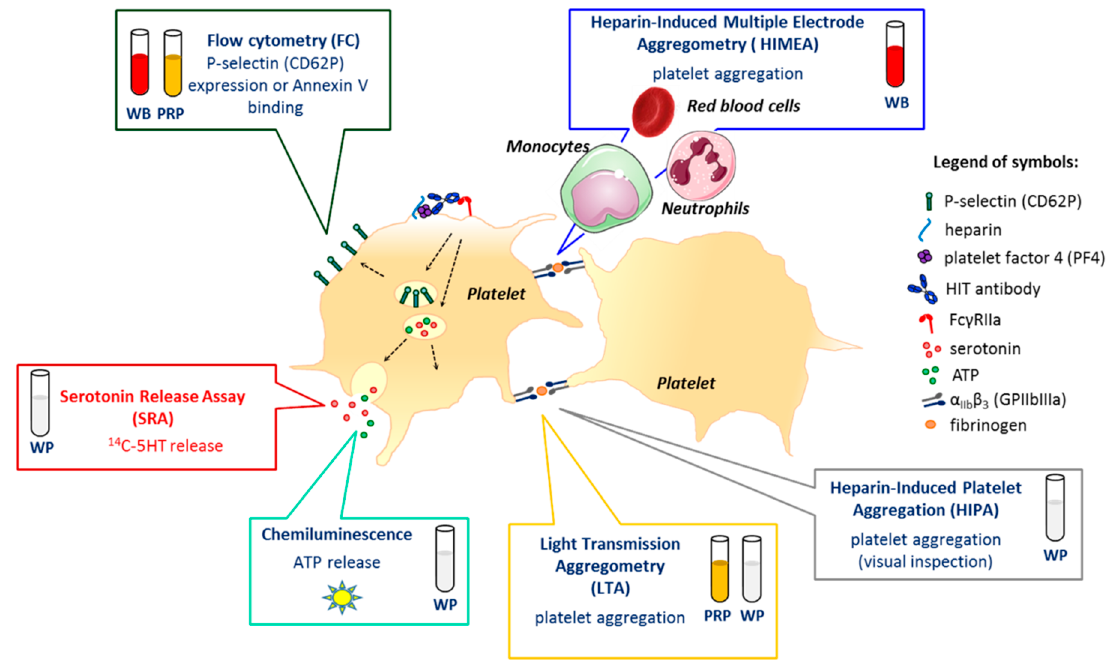
Figure 1. Platelet responses induced by heparin-induced thrombocytopenia (HIT) antibodies and functional assay targets. Depending on the assay, donors’ platelets are stimulated either in whole blood (WB), platelet-rich plasma (PRP), or after washings (washed platelets, WP). Today, serotonin release assay (SRA), which measures the release of serotonin from dense granules when platelets are activated, and heparin-induced platelet aggregation (HIPA), which is based on a visual inspection of platelet aggregates, are considered the “gold standard” to confirm HIT. The oldest but probably the most used assay is light transmission aggregometry (LTA), classically performed with PRP, but which still can also be carried out with WP. Platelet aggregation can also be assessed in whole blood using heparin-induced multiple electrode aggregometry (HIMEA), which considers the possible contribution of monocytes, neutrophils, and red blood cells (RBC) to platelet activation induced by HIT antibodies. Dense granules secretion may also be evaluated by measuring the ATP released using chemiluminescence. Several assays based on flow cytometry (FC) have also been proposed, most of them assessing P-selectin (CD62P) expression or Annexin V binding to phosphatidylserine on the surface of activated platelets.